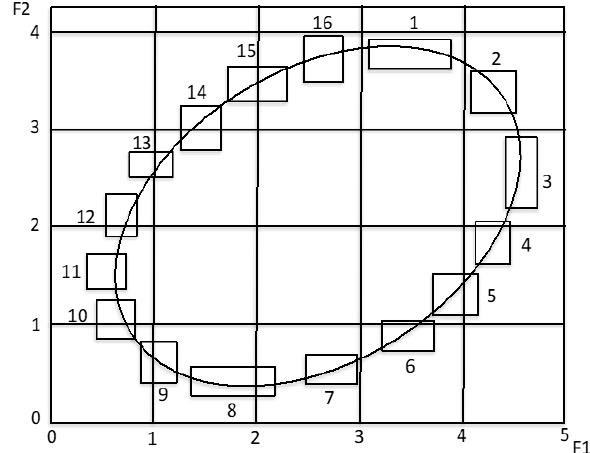
Table 3. Oval artificial data.